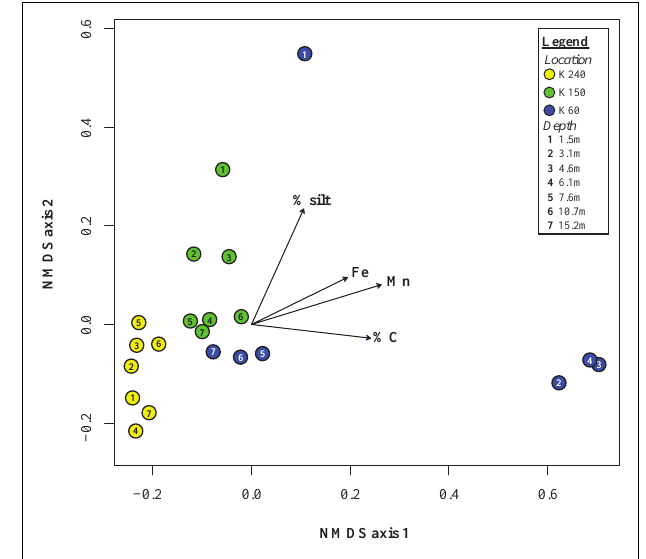
FIGURE 6 |This non-metric multidimensional scaling (NMDS) ordination shows that the bacterial communities cluster based on well location. Each point on the ordination is a different bacterial community (n = 21), and the location of the points is based on UniFrac distances.The points are colored based on well location. In addition, the vectors on the ordination represent the gradient in the chemical variables for all the samples in the